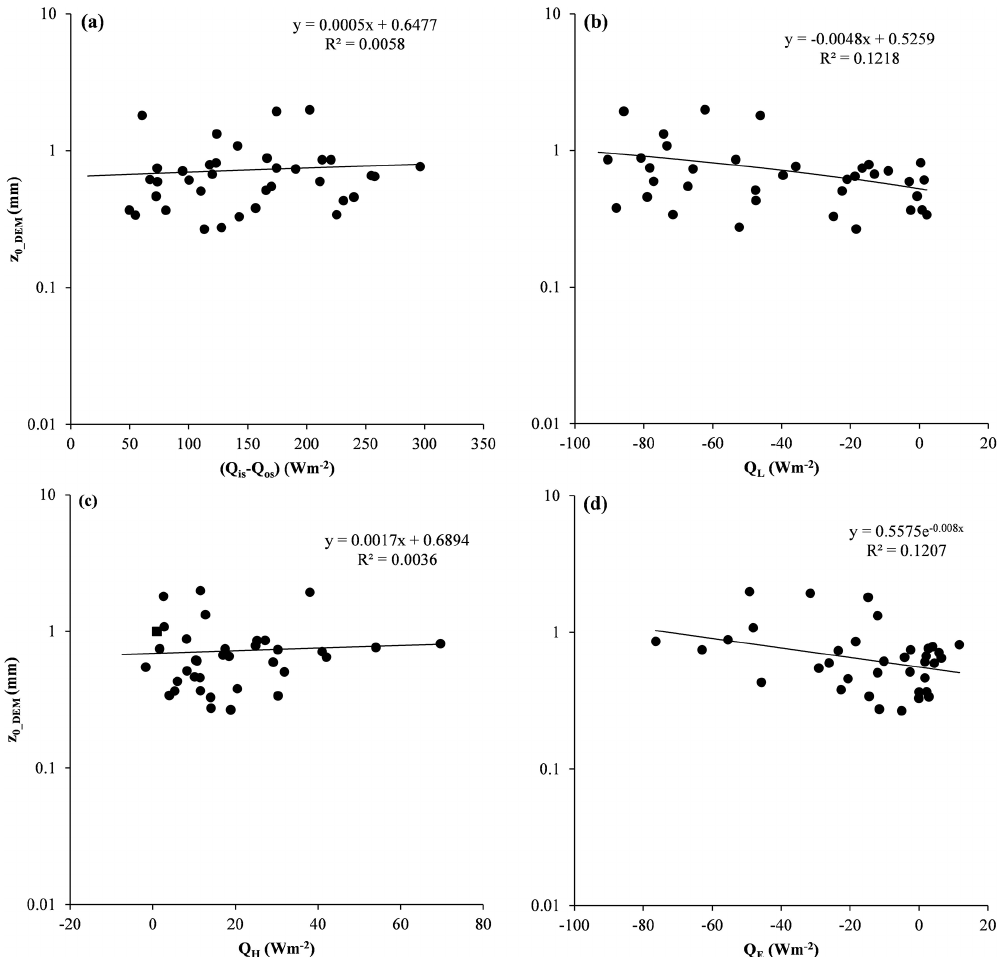
Figure 11. Daily upward wind direction of DEM-based z 0_DEM vs. energy inputs: (a) z 0_DEM vs. net shortwave radiation, (b) z 0_DEM vs. net longwave radiation, (c) z 0_DEM vs. bulk-method-calculated sensible heat and (d) z 0_DEM vs. bulk-method-calculated latent